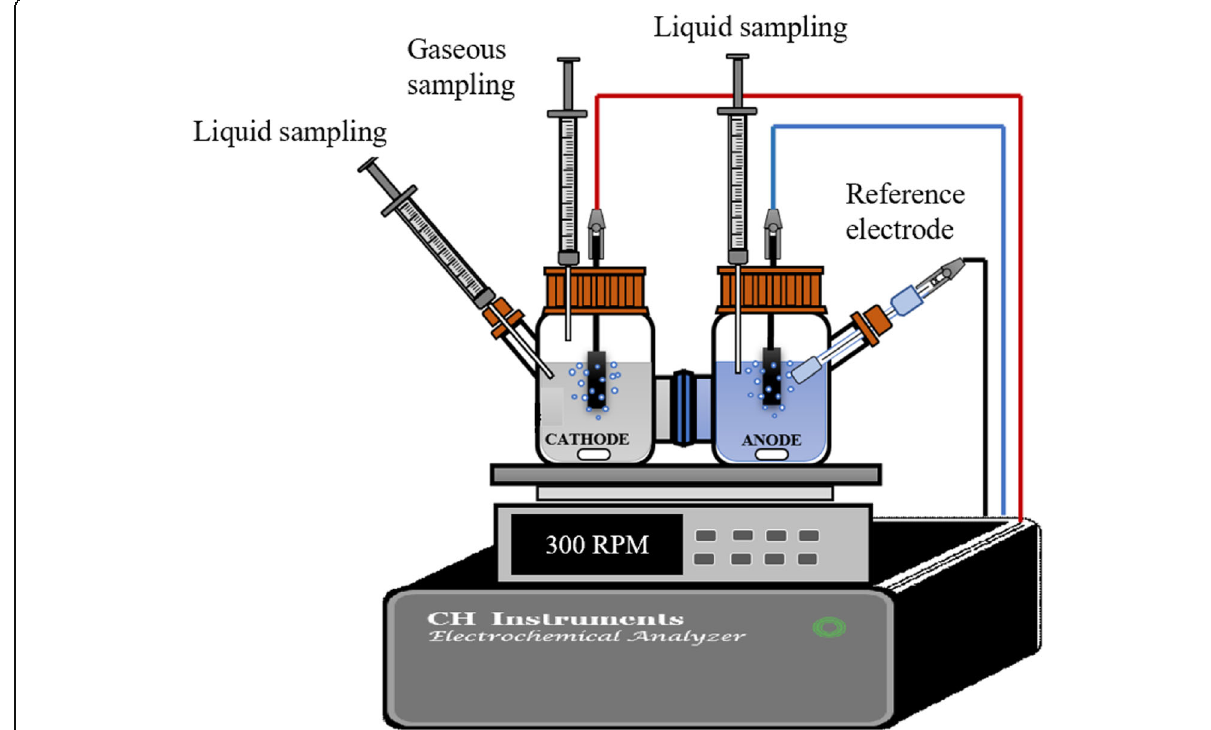
Fig. 2 Schematic diagram of the electrochemical system used in the